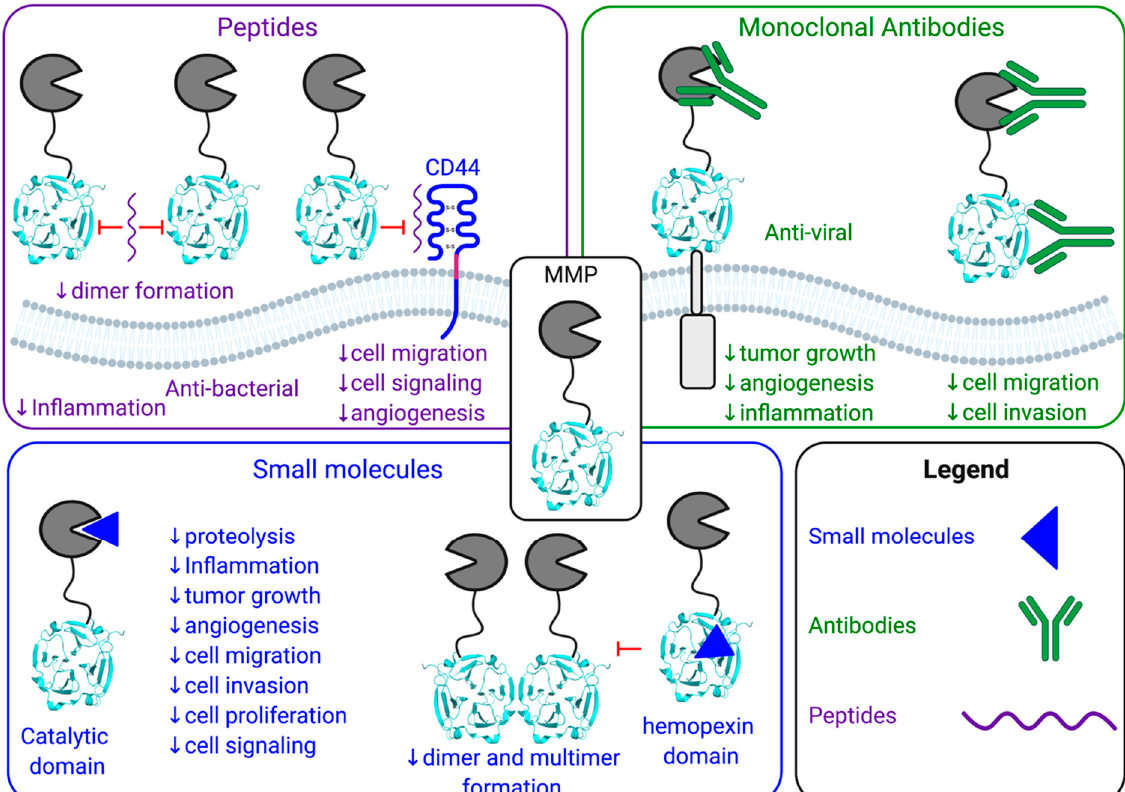
Figure 3. Schematic of three pharmacological approaches to inhibit the biological functions of MMPs: peptides (purple), monoclonal antibodies (green) and small molecules (blue). Table 1. MMPs inhibitors in clinical trials.